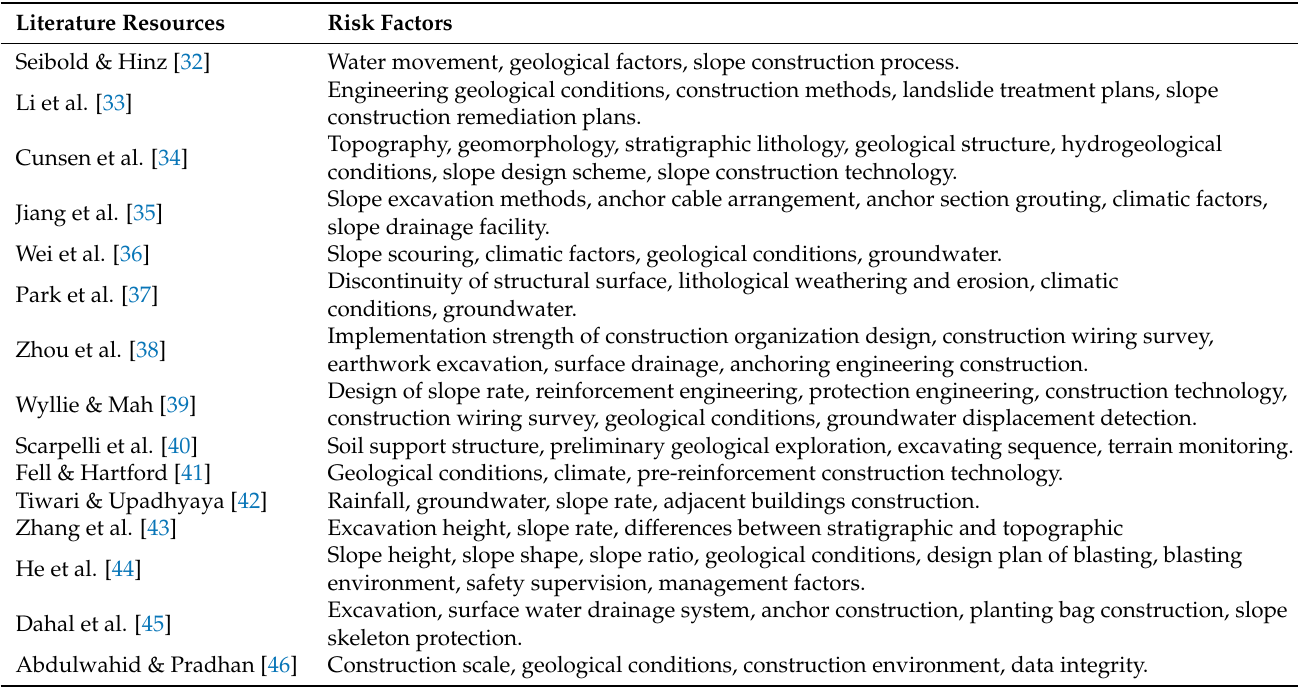
Table 2. Construction safety risk factors based on literature.